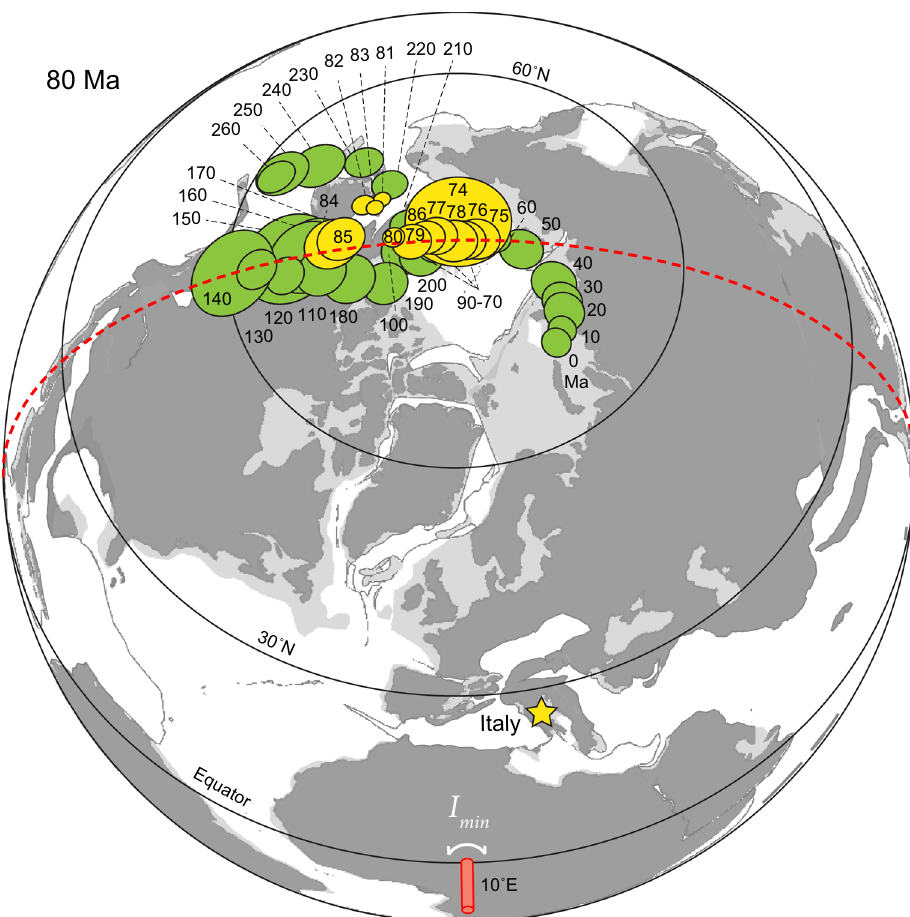
Fig. 3 Mesozoic true polar wander. Reconstruction at 80 Ma, centered at 10°E palaeolongitude, showing globally averaged palaeopoles 72 (green) exhibiting oscillations interpreted as earlier Mesozoic TPW events 22 . Italy and its new poles (yellow) reconstructed using Euler parameters (4.0°N, 32.6° W, 21.8°CW) in a global plate model with simpli fi ed Mediterranean motions guided by ref. 71 . All Italian poles are from Apiro except 85 and 84 Ma from Furlo that fi ll the gap at Apiro (Supplementary Fig. 2). Error ellipses are projections of cones of 95% con fi dence interval. Present-day TPW axis (minimum moment of inertia, I min ) at 0°N, 10°E and orthogonal plane of TPW in red 4,25 . Note consistency of TPW longitude in all datasets. Supplementary Data 3 for